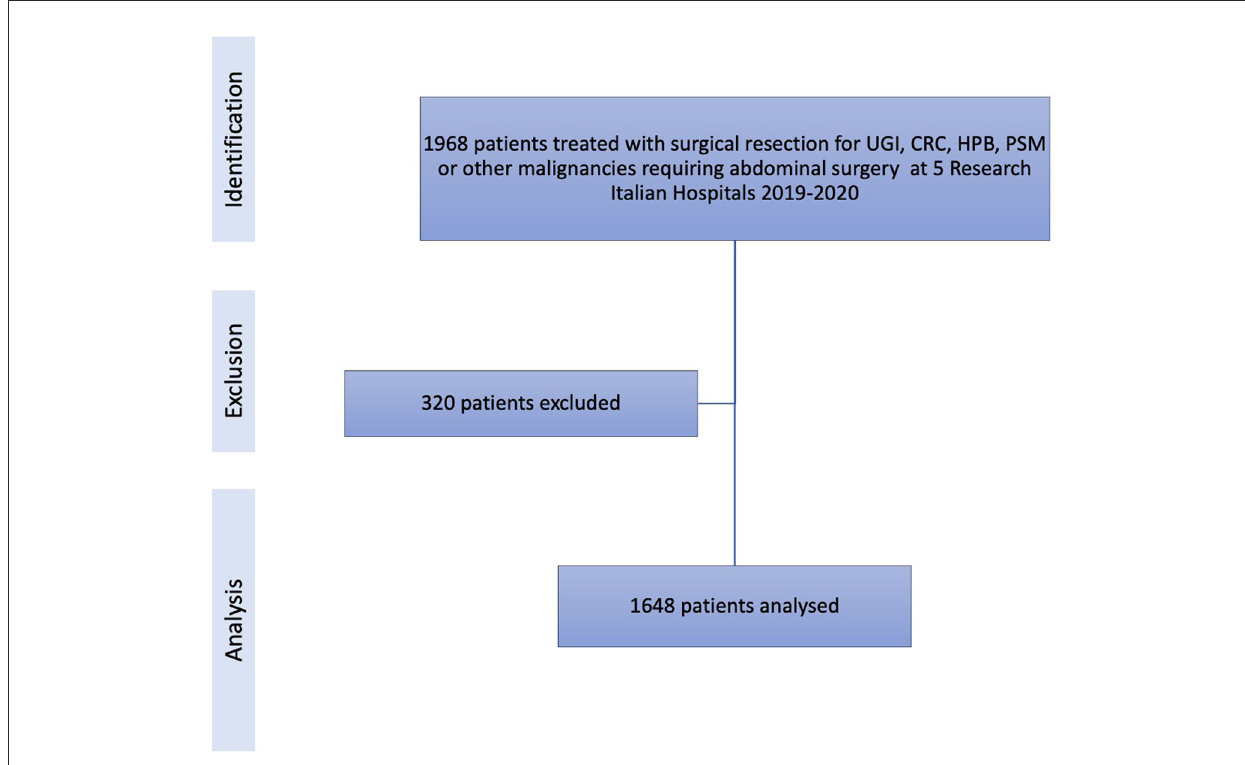
FIGURE1 STROBE flowchart of the study population showing identification of the cohort, exclusion of patients, and the final selection of patients analyzed.